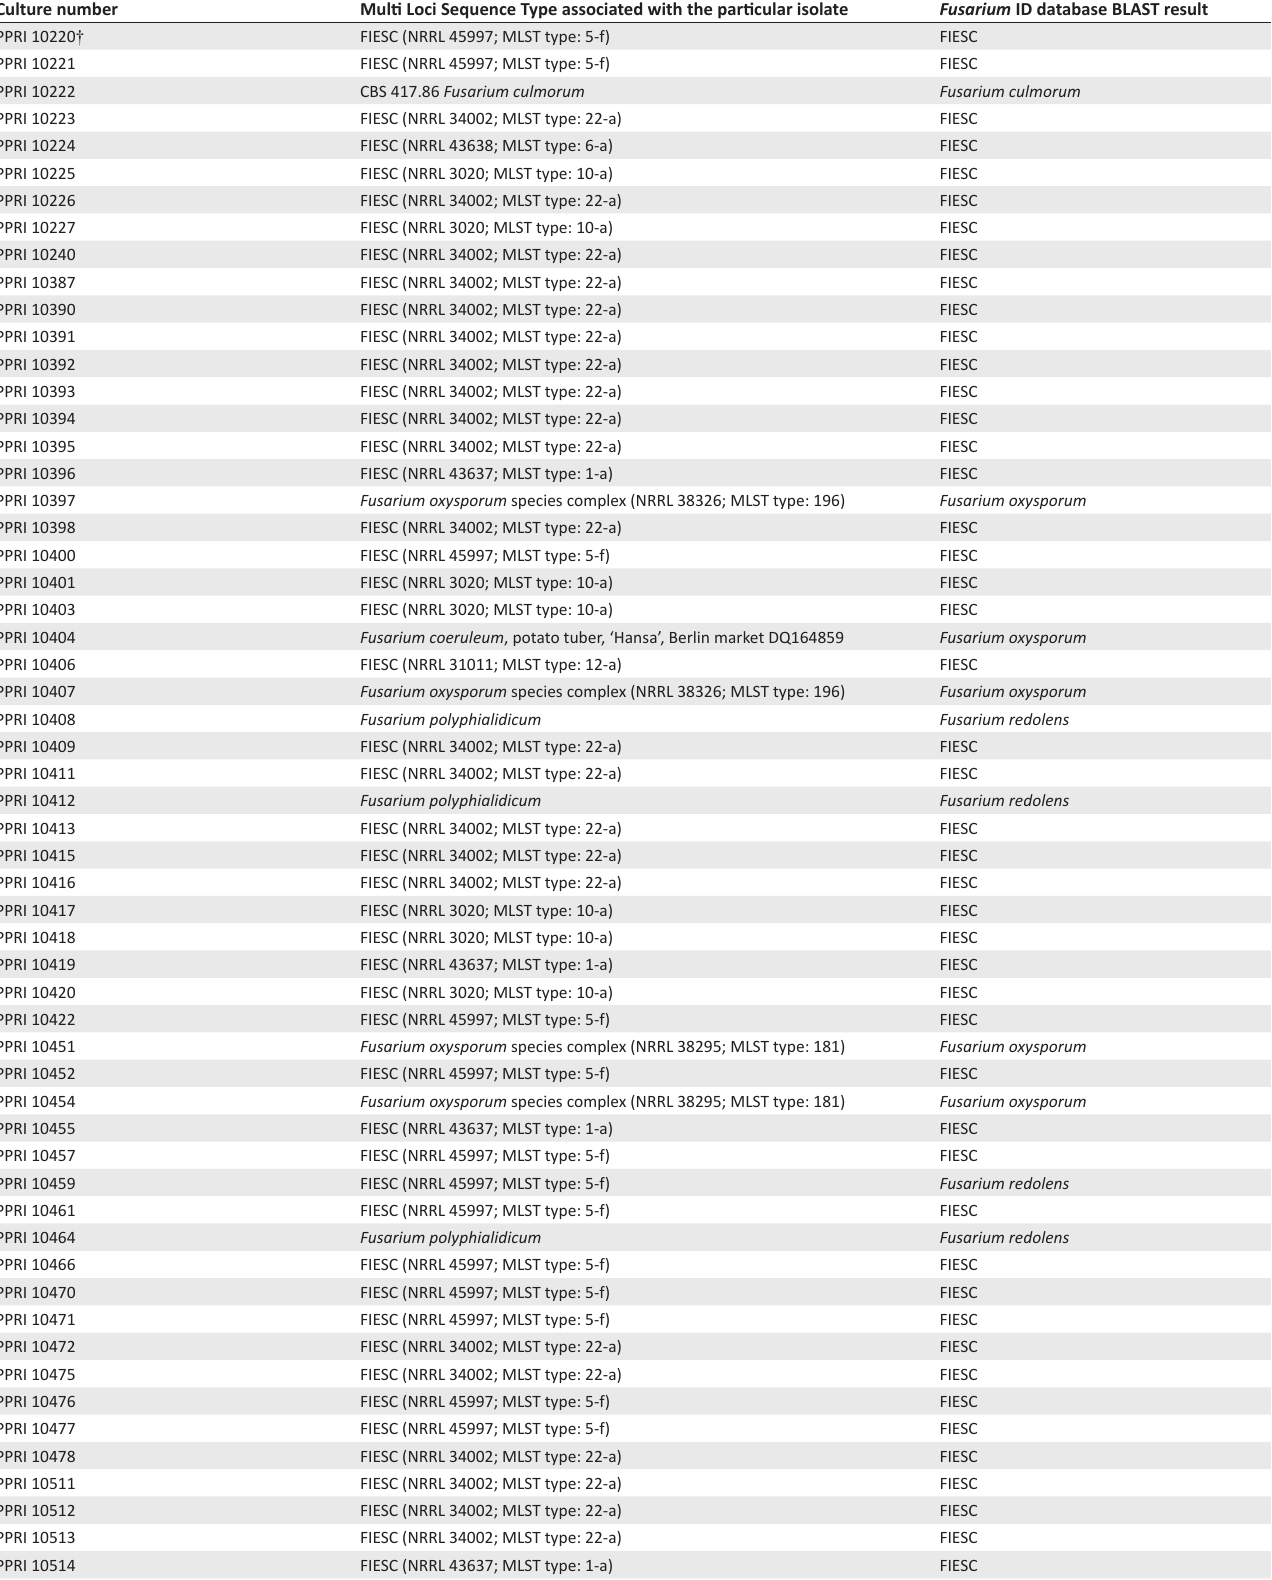
TABLE 2: Molecular identification of Fusarium isolates based on translation elongation factor sequence data.